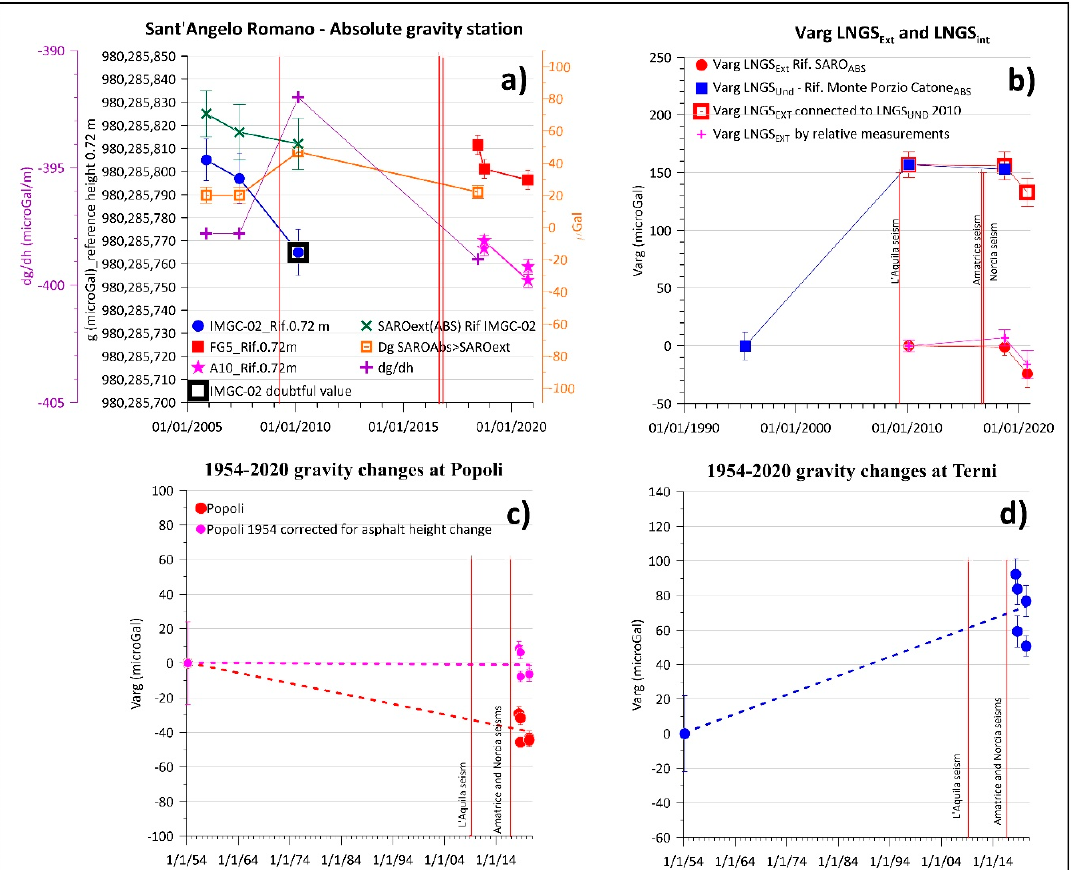
Figure 6. ( a ) Long term gravity changes at the absolute station Sant’Angelo Romano (SARO) from 2005 to 2020 measured with the IMGC-02, FG5#238, and A10#39 absolute gravimeters. ( b ) Gravity changes over 1995–2010 and 2010–2020 at LNGS UND and LNGS EXT . ( c , d ) Long term gravity changes from 1954 to 2020 at the two 1954 satellite stations in Popoli and Terni, respectively; for Popoli the trend correcting the 1954 value of the elevation change due to the correction for the asphalt height change (pink symbols) is also shown (see text for details). The vertical red lines in each figure mark the time of occurrence of the L’Aquila, Amatrice, and Norcia seismic events with magnitude M w ≥ 6.0.